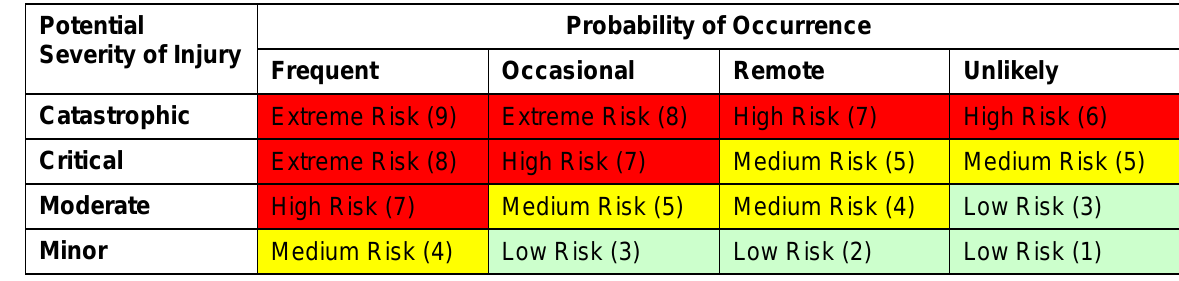
Table 1 Project Risk Matrix After McGeorge and Zou (2013); and Pinto (2002) The severity rates (SR) indicate to management the seriousness of the disabling injury